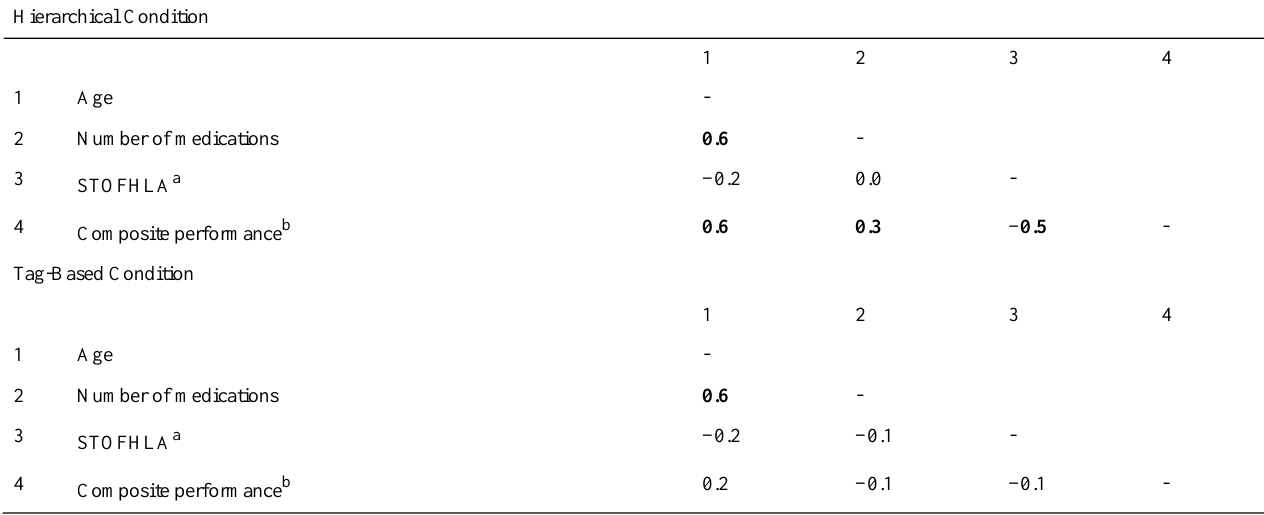
Table 3. Correlations between health literacy and knowledge and performance in hierarchical and tag-based conditions Hierarchical